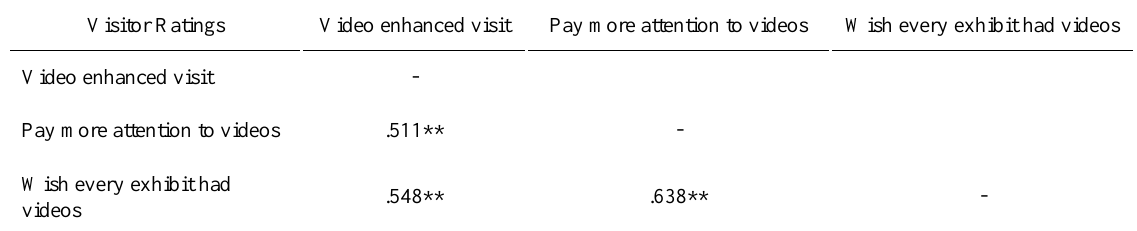
Correlations Between Various Items Relating to Visitor Preferences for Videos at the Exhibit Space Visitor Ratings Video enhanced visit Pay more attention to videos Wish every exhibit had videos Video enhanced visit - Pay more attention to videos .511** - Wish every exhibit had .548** .638** - videos Note : ** p < .001